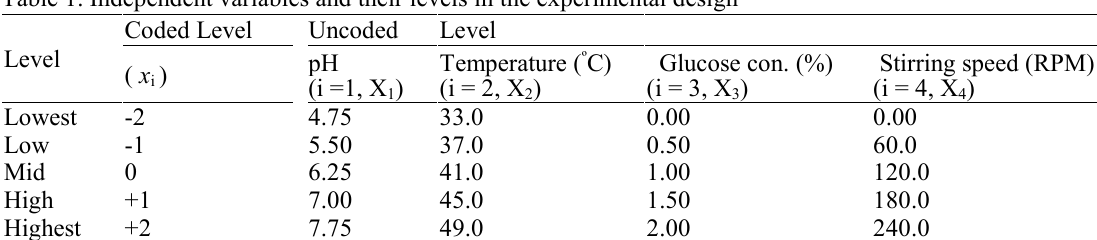
Table 1. Independent variables and their levels in the experimental